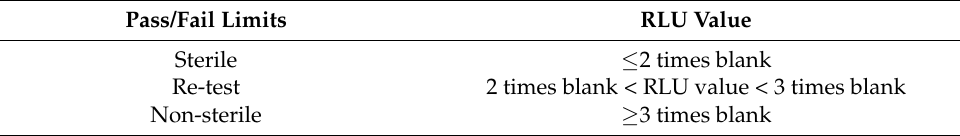
Table 2. Pass/fail limits for the RLU